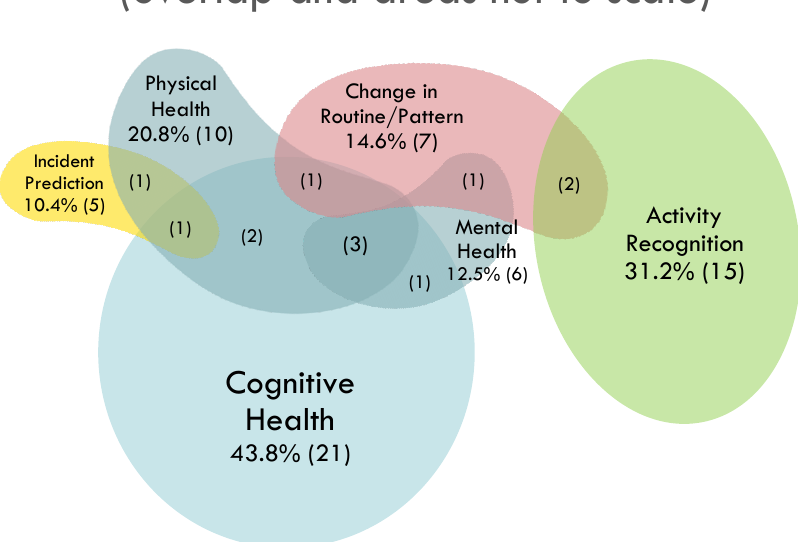
Figure 2. Behavioural outcomes in studies using RTLS for health status monitoring. The percent (number) of studies in each outcome category are provided, and the number of overlapping studies are provided in brackets in the areas of